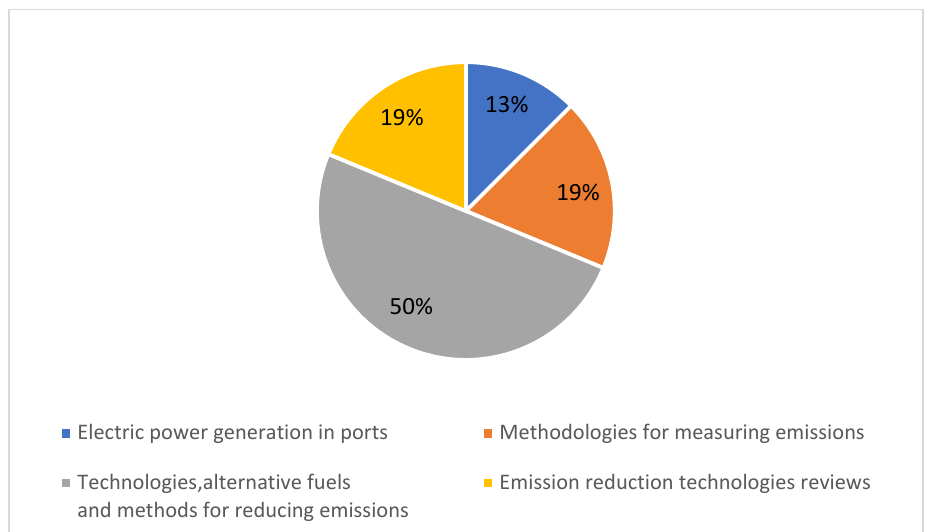
Figure 7. Emission reduction subdomains.